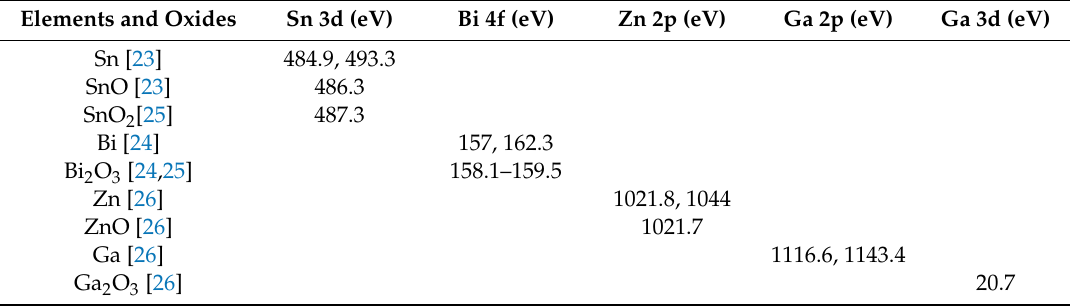
Table 3. XPS curves of related elements and oxides in the experiment.